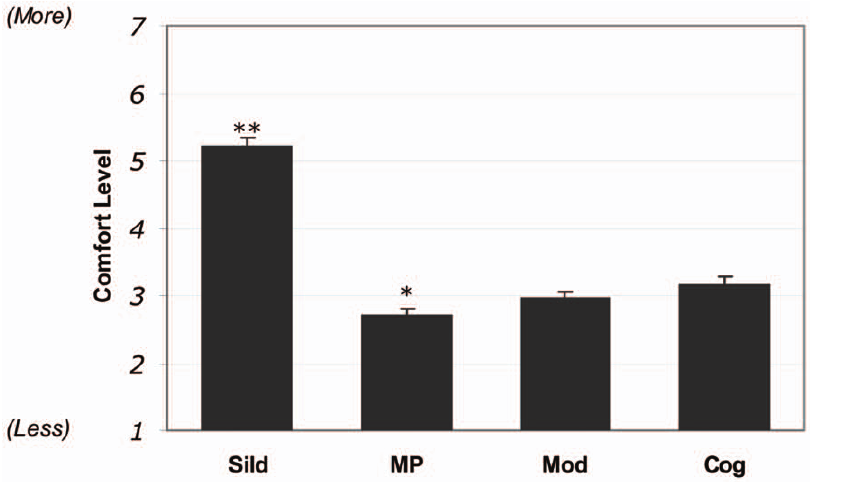
Figure 2. Physicians’ Comfort Rating with Prescribing Sildenafil, Methylphenidate, Modafinil, and a Hypothetical Cognitive Enhancer. Physicians reported being significantly more comfortable prescribing sildenafil compared to the other 3 drugs (P , 0.001); while methylphenidate was rated significantly lower (P , 0.01) when compared with sildenafil and the cognitive enhancer, but not modafinil. doi:10.1371/journal.pone.0014322.g002 PLoS ONE |